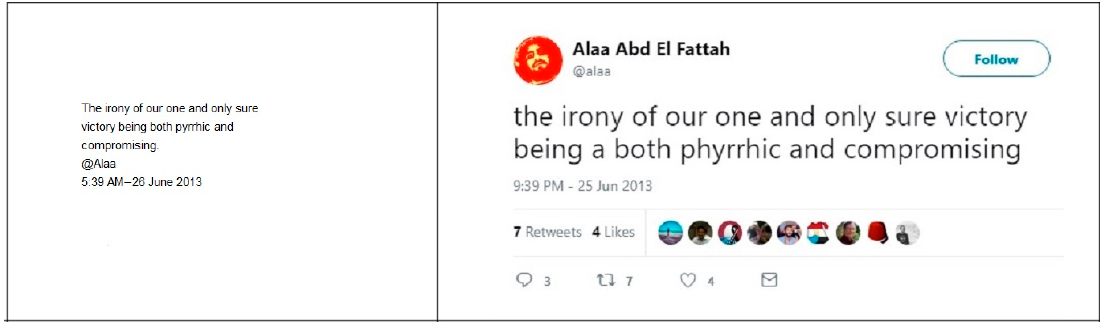
Figure 4. ( Left ) p. 183 of The City Always Wins ; ( Right ) Alaa tweet about a ‘phyrrhic [ sic ] victory’. 25 June 2013.